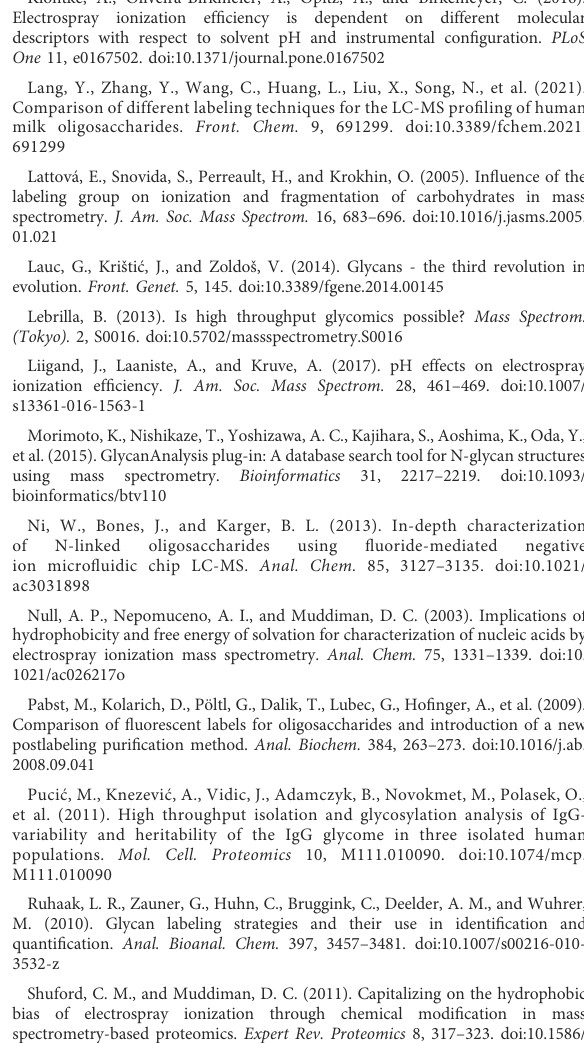
SUPPLEMENTARY FIGURE S1 Mass spectra of mono-galactosylated N-glycan with previously validated diagnostic product ion for 6-arm composition highlighted: (A) FA2[6] G1 in negative MS mode, (B) FA2[3]G1 in negative MS mode, (C) FA2[6]